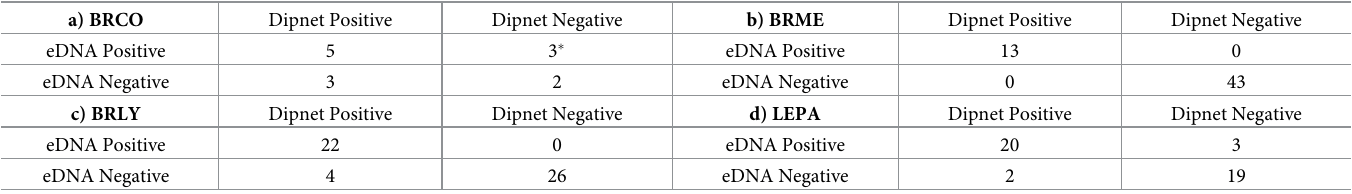
Table 5. Comparative results between eDNA (E) and dip-net (D)